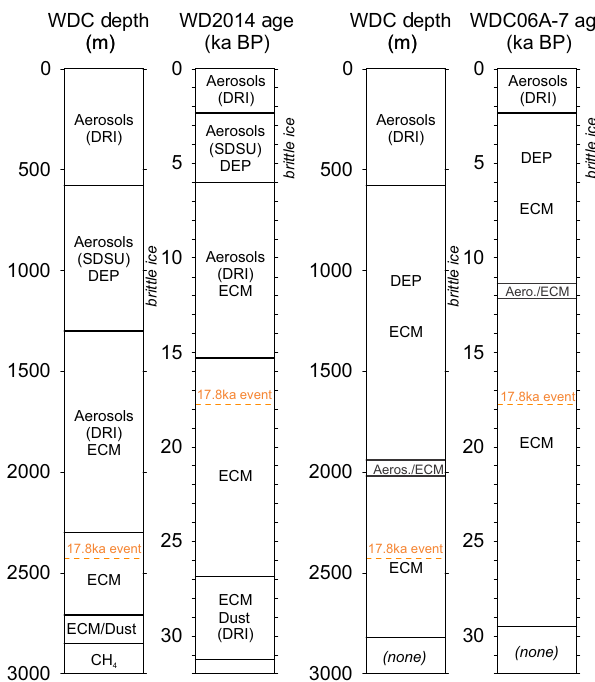
Figure 1. Overview of the data sets used for development of WAIS Divide annual-layer dating chronologies. Left: depth and age in- formation for the WAIS Divide aerosol records obtained at the Desert Research Institute (DRI) and South Dakota State Univer- sity (SDSU), and ECM–DEP (electrical conductivity measurement– dielectric profiling) data used to establish the new WD2014 chronology. Right: data sets used for development of the previous WDC06A-7 chronology. Also shown is the position of the acidity anomaly (17.8ka event), a major chronostratigraphic age marker across West Antarctica (Hammer et al., 1997; Jacobel and Welch, 2005). Aerosol data below 2300m (>15ka) are from insoluble par- ticle measurements (i.e. dust)